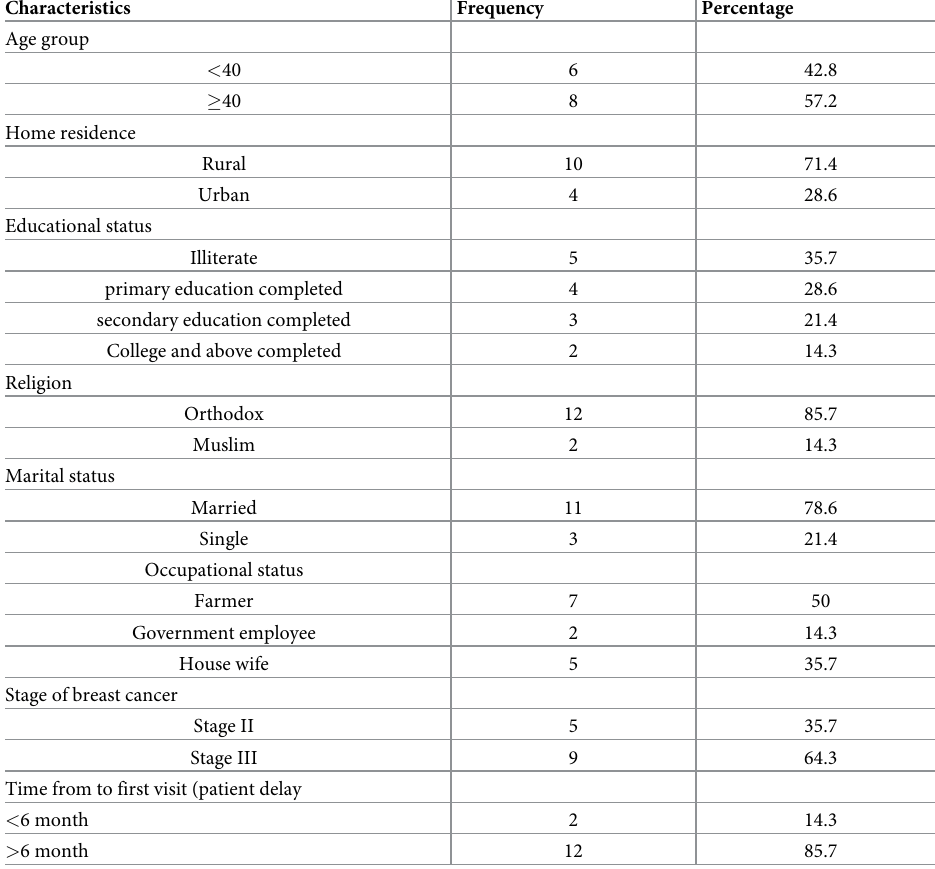
Table 1. Socio-demographic characteristics of breast cancer patients diagnosed at University of Gondar and Felege Hiwot Specialized hospitals North-west Ethiopia, 2019.